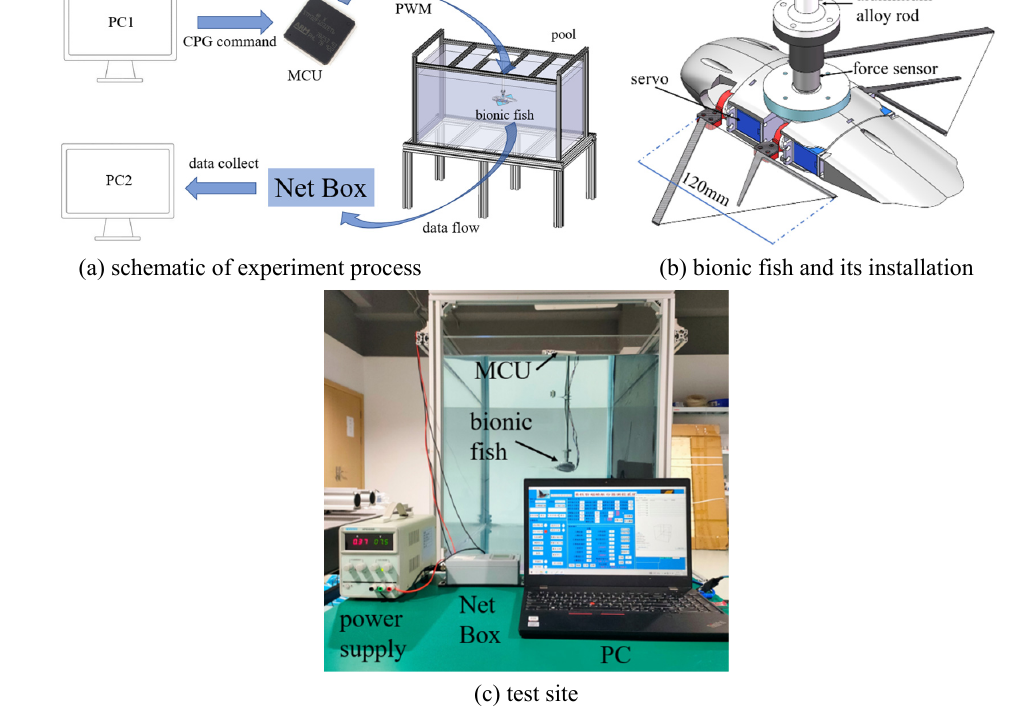
Figure 5. Experiment system.